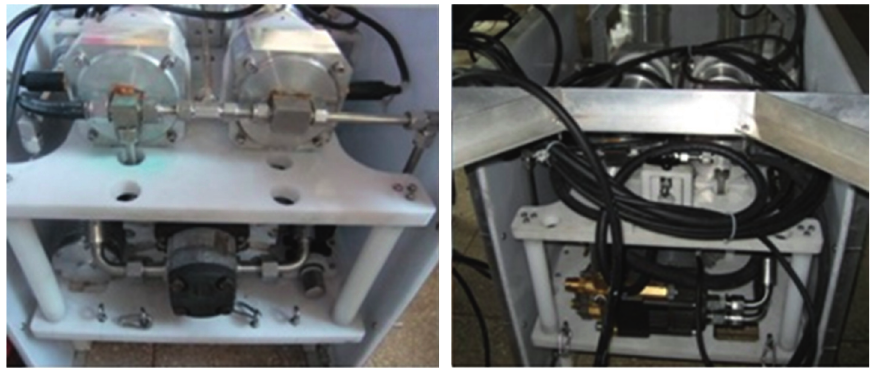
Figure 10: Prototype of the buoyancy regulation system.